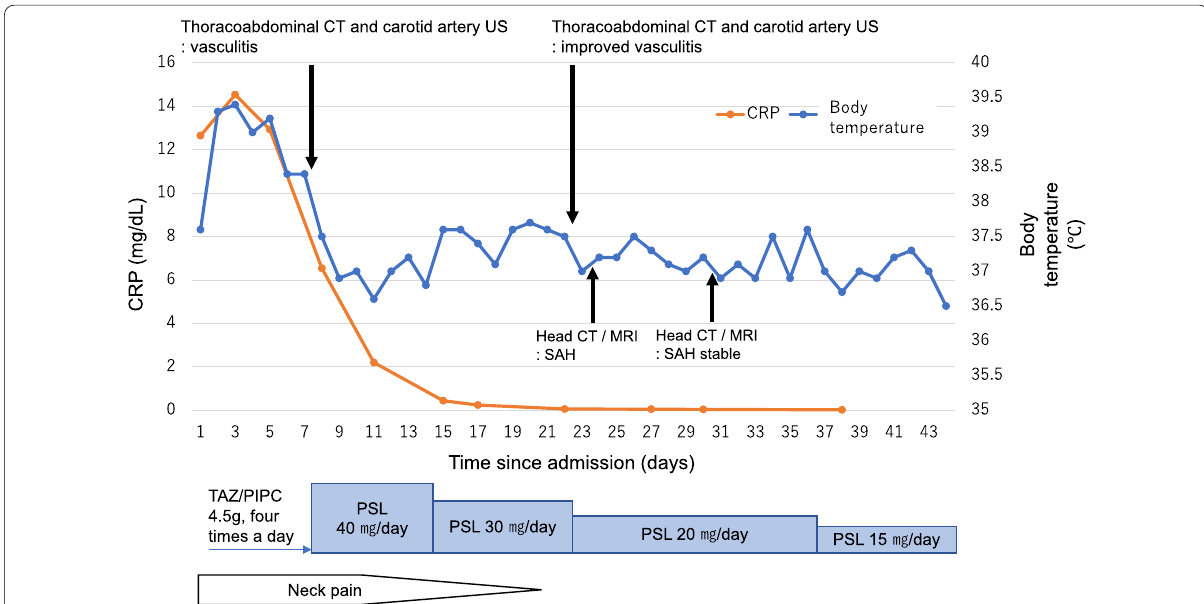
Fig. 1 Disease course after admission. After admission, the patient received intravenous drip infusion of TAZ/PIPC; however, her fever, CRP level, and neck pain did not improve. On the 8th day of hospitalization, contrast-enhanced CT and cervical US showed vasculitis, and treatment with PSL 40 mg/day was started. On the 24th day, MRI of the head revealed SAH and vascular irregularity in the basilar artery. After contrast-enhanced CT and cervical US showed improvement in the vascular wall thickening, and the head MRI scan showed a trend toward improvement in the vascular irregularity, the patient was discharged on the 44th day. CRP C-reactive protein, CT computed tomography, MRI magnetic resonance imaging, PSL prednisolone, SAH subarachnoid hemorrhage, TAZ/PIPC tazobactam–piperacillin; US